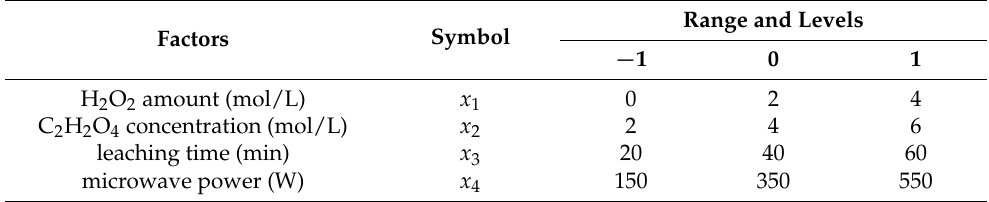
Table 2. Independent factors and levels for design. Factors